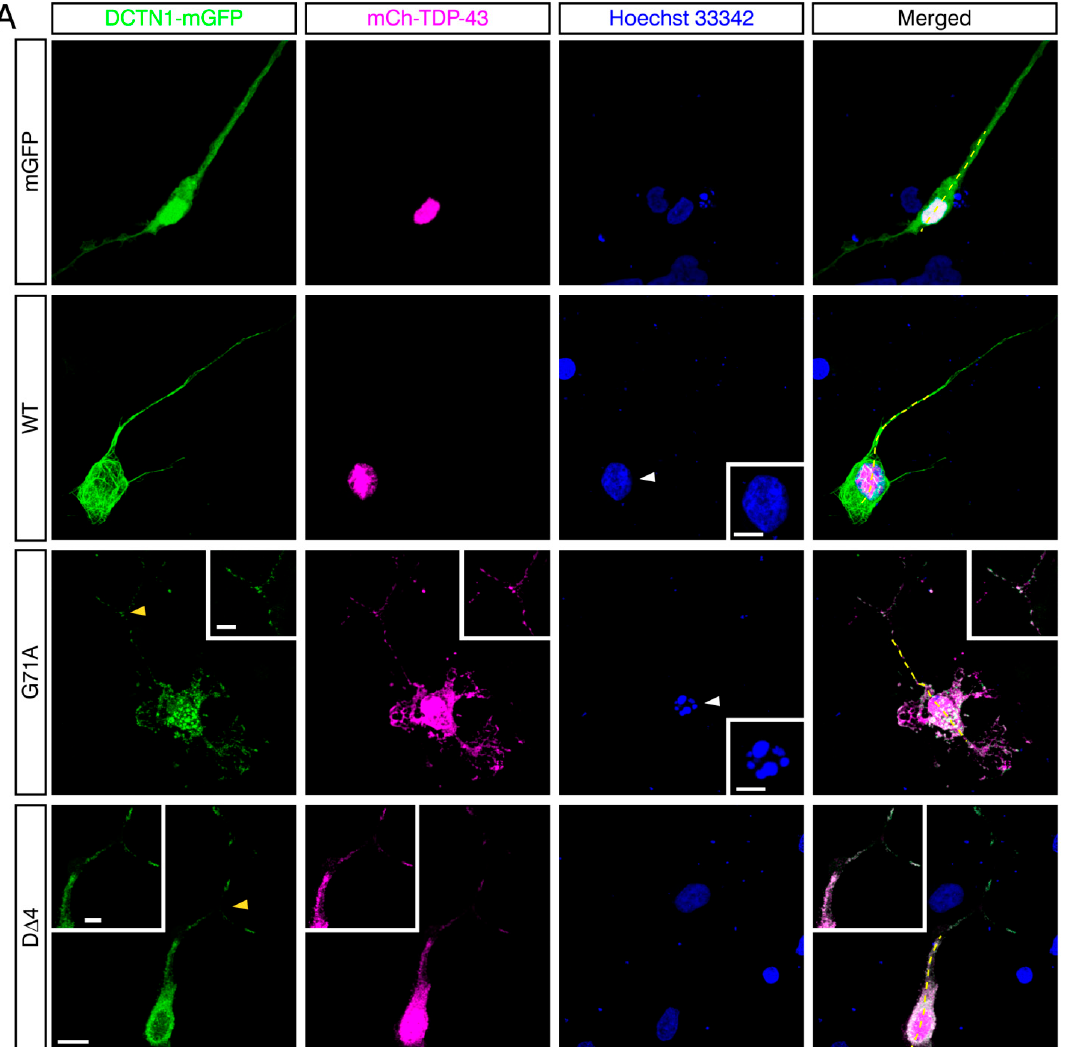
Figure 6. Human iPSC-based modeling of Perry disease. Coexpression of mutant DCTN1 tagged with mGFP and mCherry-tagged wild-type TDP-43 caused cytoplasmic mislocalization and aggregation of TDP-43 in neurons differenti- ated from NEUROG2 -inducible human iPSCs. The transfected cells were cultured for two days under nonstressed condi- tions, fixed, and subjected to confocal microscopy. ( A ) Maximum-intensity projections of deconvoluted z-stack confocal